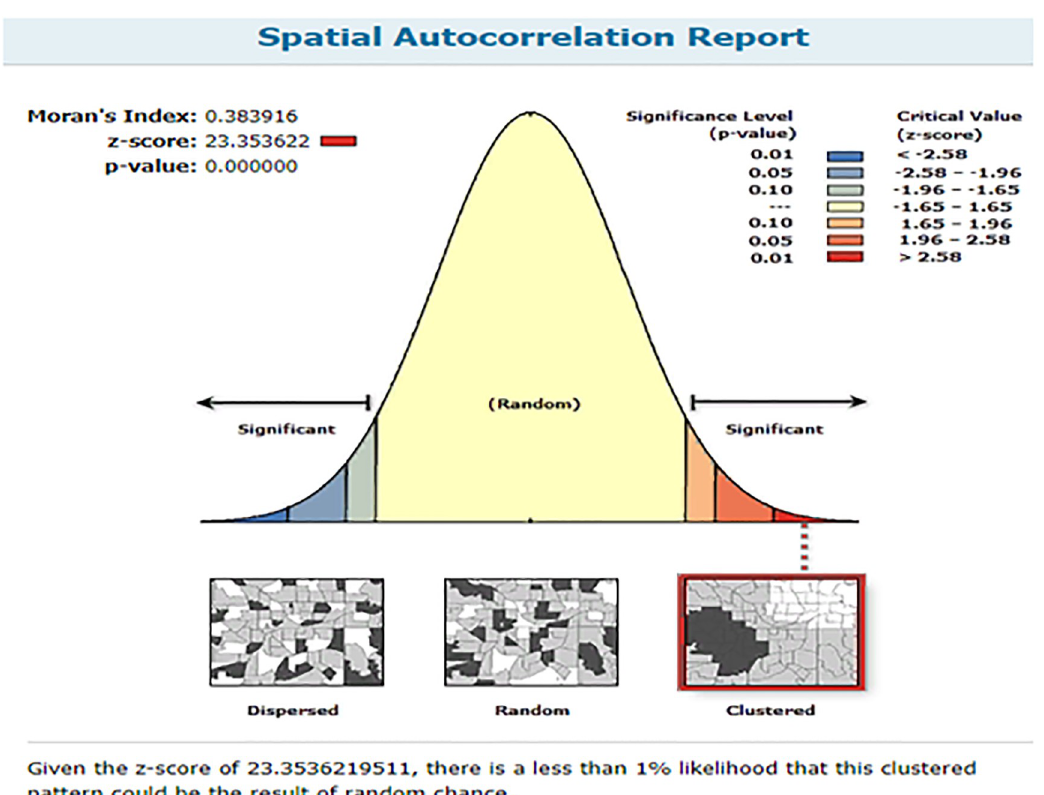
Fig 5. Spatial autocorrelation of anemia among reproductive age women in Ethiopia, EDHS